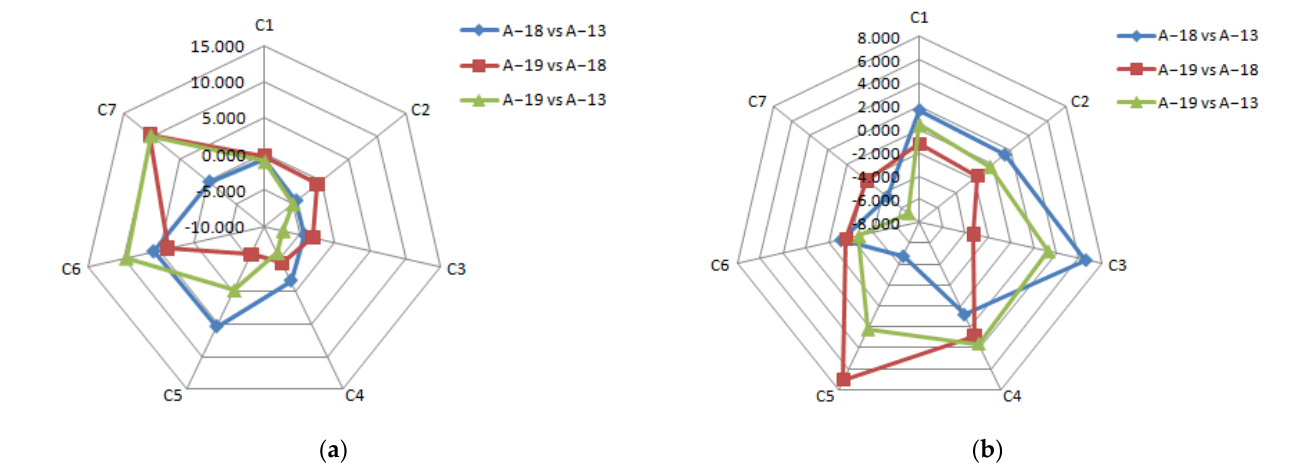
Figure 7. Circular chart of comparative variation of land areas of the pasture category, in relation to NDVI quality classes; ( a ) plot P808; ( b ) plot P816.